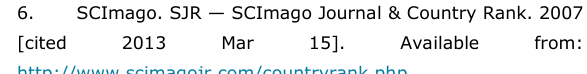
Figure 5: The number of cell phone subscriptions (in millions) for each of the Central Asian